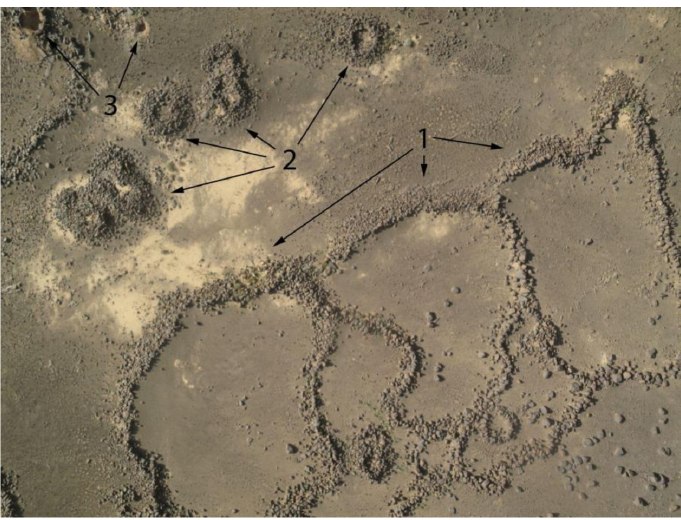
Figure 8. Example of images collected during the survey. This shot was taken by the fixed-wing drone over Mesa 4 (Maitland’s Mesa) and shows (1) “garden walls”, (2) ghura (local Arabic term for the mesas) huts, and (3) evidence of recent